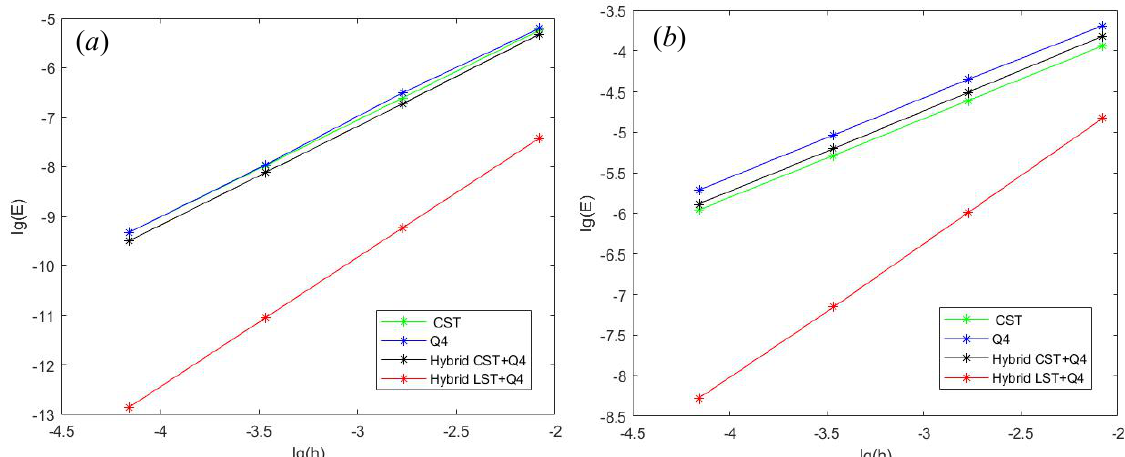
Figure 4. Hybrid-element numerical convergence comparison diagram ( a ) displacement numerical convergence comparison diagram ( b ) Von Mises stress numerical convergence